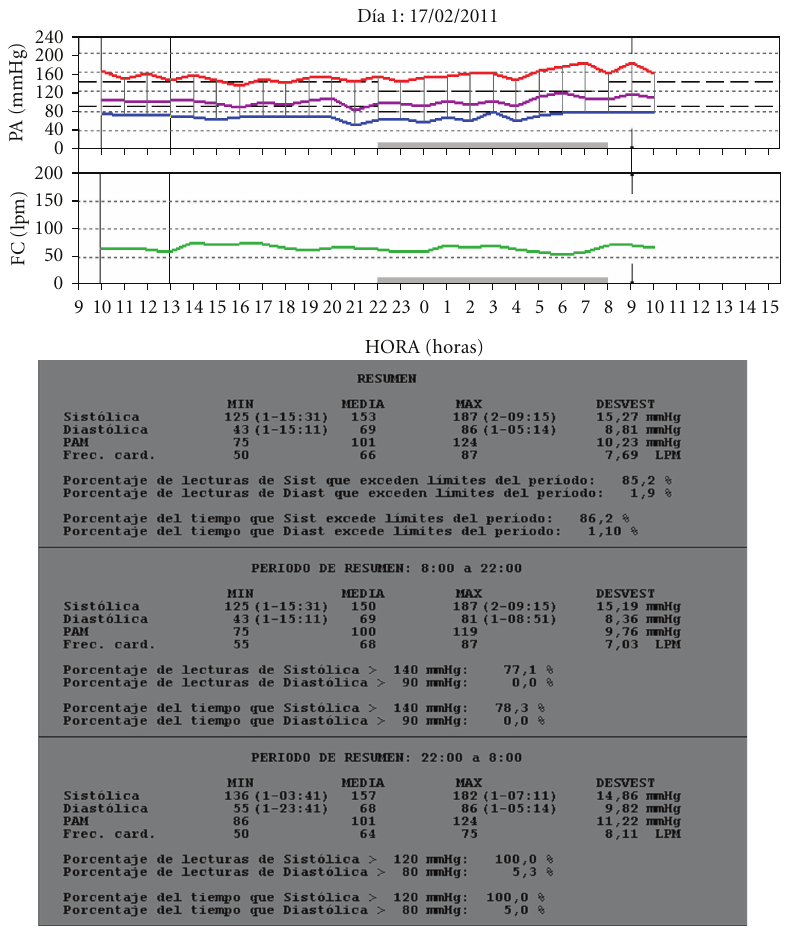
Figure 1: Patient aged 78 years with isolated systolic hypertension and riser